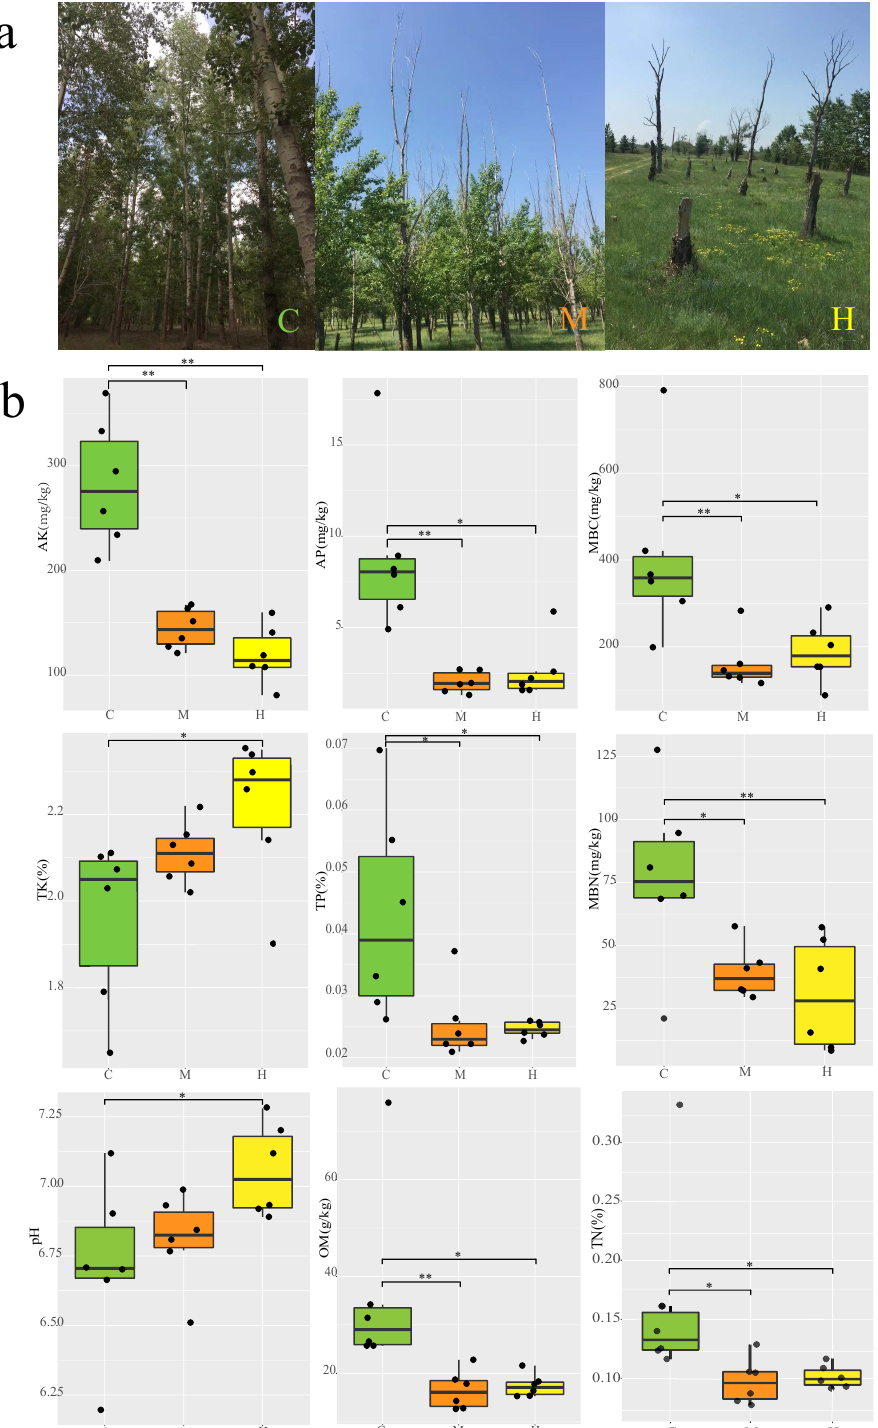
Figure 1. Poplar tree growth conditions at the sampling site and comparison of physical and chemical factors between groups. ( a ) Actual diagram of different growth states of poplar. Poplars in undegraded condition (C); Medium-degraded poplars from the treetop (M); Completely degraded poplars (H); ( b ) variation in soil properties between different groups, with different parallel samples in the group set as the black dots. ** p < 0.01, * p < 0.05 (After Shapiro-Wilk and Levene’s test, Anova with LSD method or Kruskal–Wallis tests and multiple comparison with Bonferroni method were carried